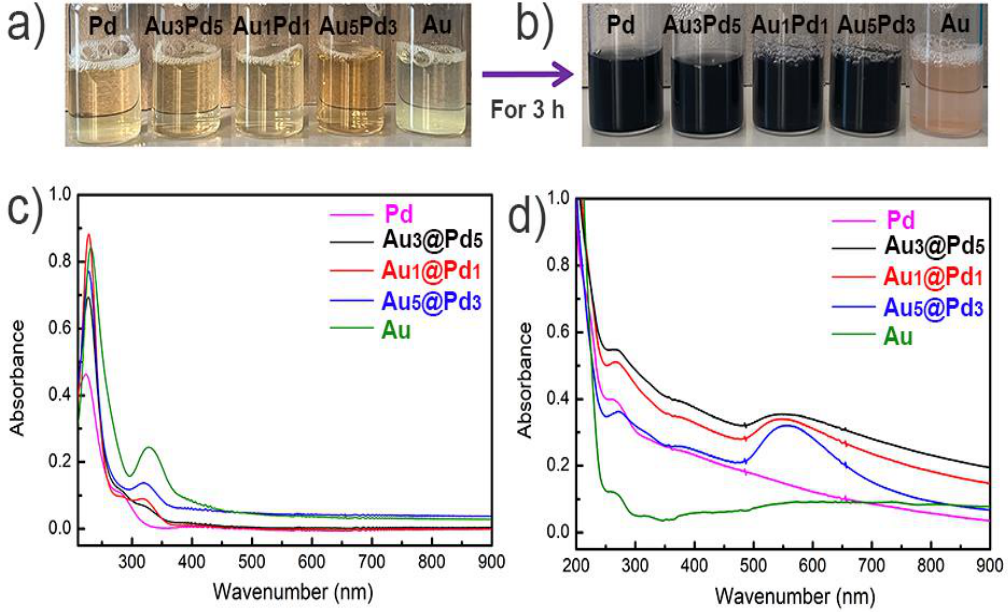
Figure 3. Images and UV-vis spectra in Pd, Au 3 @Pd 5 , Au 1 @Pd 1 , Au 5 @Pd 3 DNPs and Au NPs of ( a , b ) before reaction and ( c , d ) after reaction.